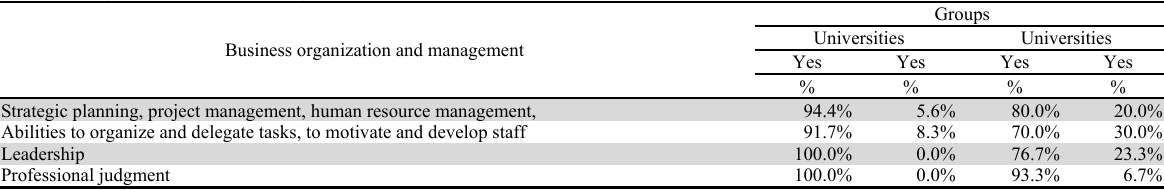
Business organization and management